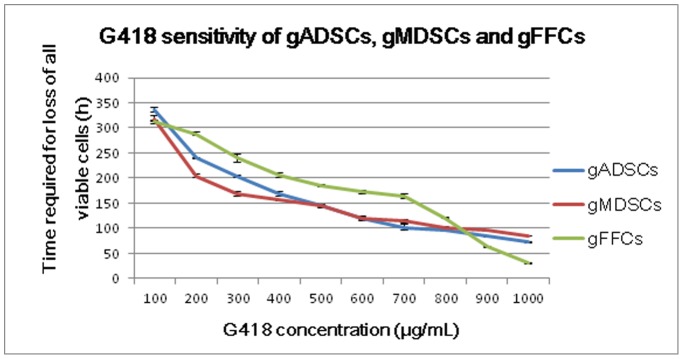
G418 sensitivity of gADSCs, gMDSCs and gFFCs.For gADSCs, 400 μg/mL G418 was detected by day 7 and was selected as the optimal screening concentration for transgenic cell clones. For gMDSCs, 300 μg/mL G418 was selected as the optimal screening concentration. For gFFCs 700 μg/mL G418 was selected. gADSCs, goat adipose-derived mesenchymal stem cells; gMDSCs, goat muscle-derived satellite cells; gFFCs, goat fetal fibroblast cells.